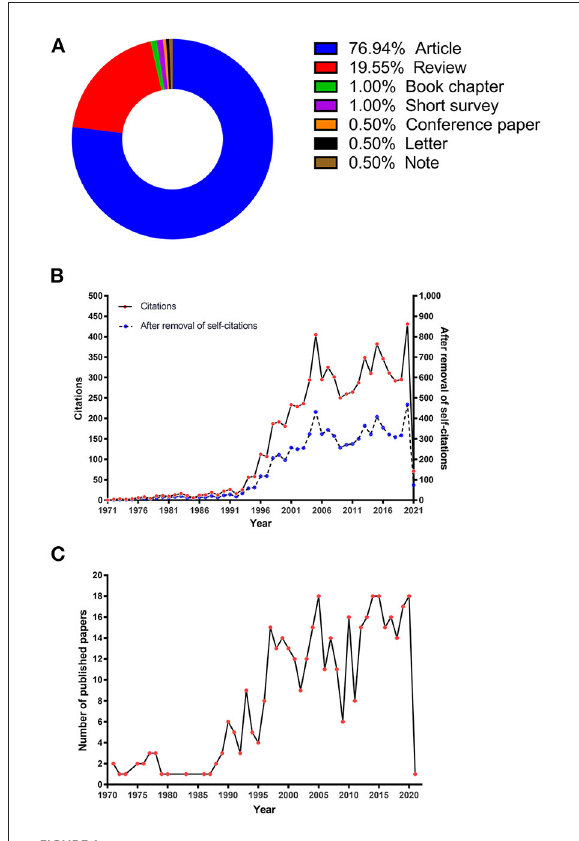
FIGURE1 Citation characteristics of the papers on DIGO. (A) The frequency of paper types. (B) The number of citations and that after removal of self-citations of papers by year of publication. (C) The number of papers included by year of